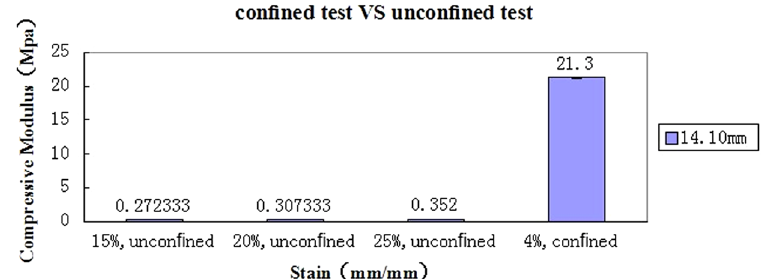
Figure 1. The tangent modulus values at 15%, 20% and 25% strain in the unconfined compression group was far lower than that of the confined compression group at 4% strain.